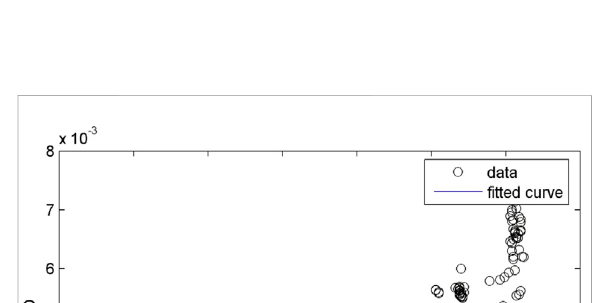
FIGURE 8 Exponential function fi tting between axial pressure and permeability.